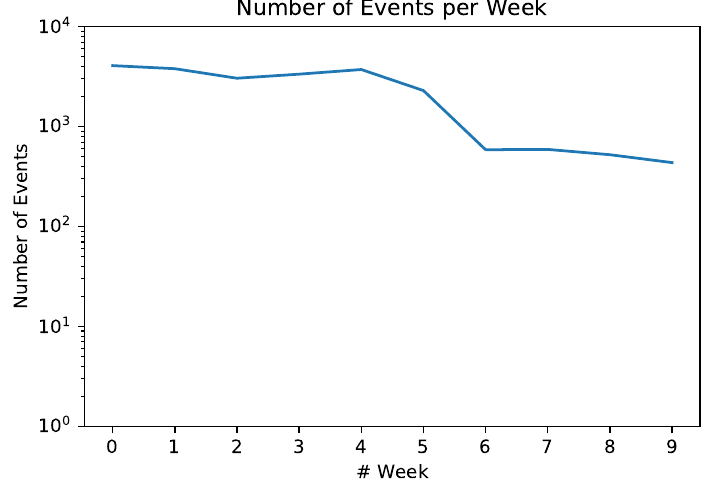
Figure 4. Schematic operation of the proposed approach over the considered tweets